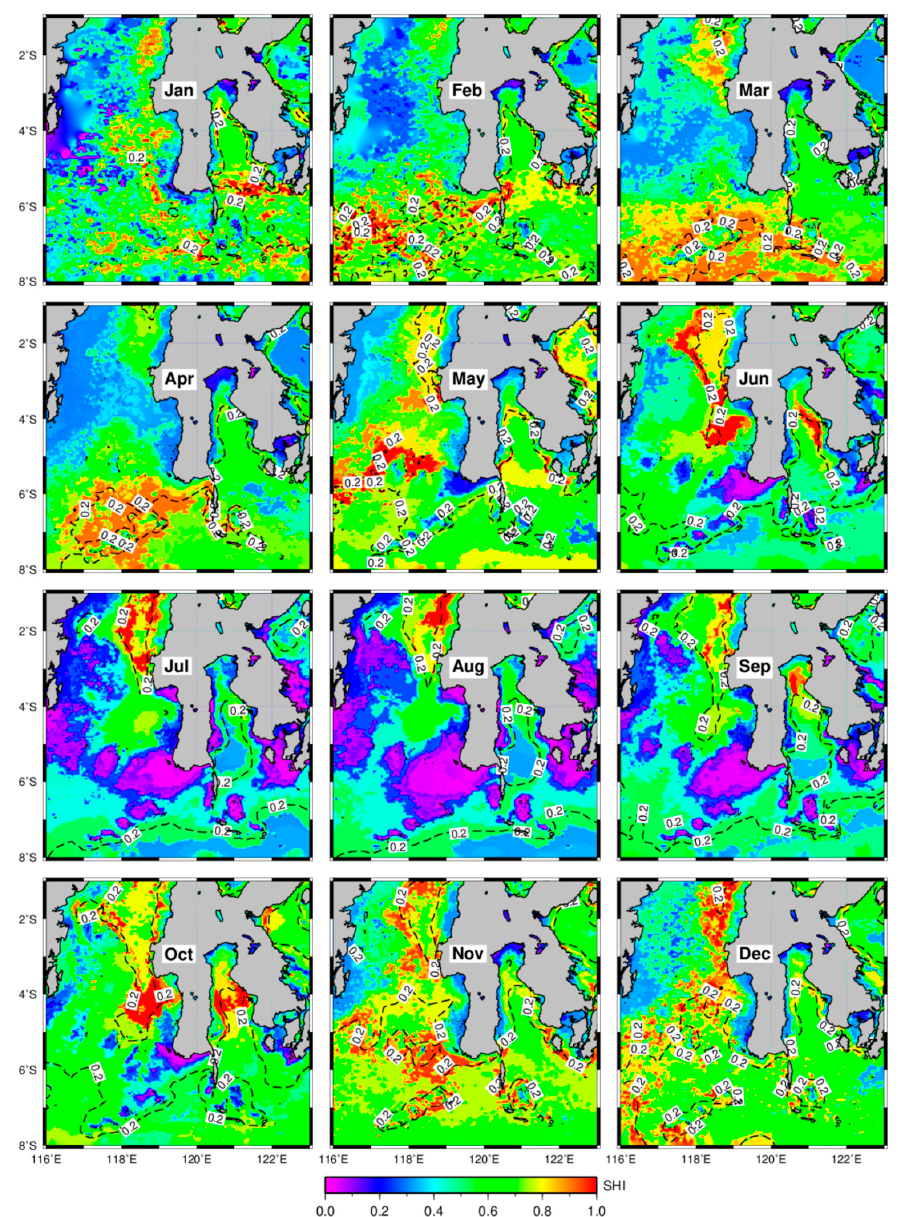
Figure 5. Spatial and temporal distribution of particular Chl-a signature 0.2 mg m − 3 overlain on predicted habitat hotspot shown as averaged skipjack habitat index (SHI) image maps from January to December 2007–2016.